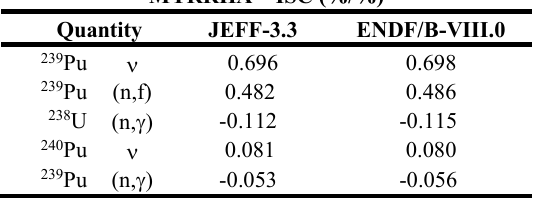
Table 1. ISC of the top 5 reactions for MYRRHA using JEFF-3.3 and ENDF/B-VIII.0 libraries. MYRRHA – ISC